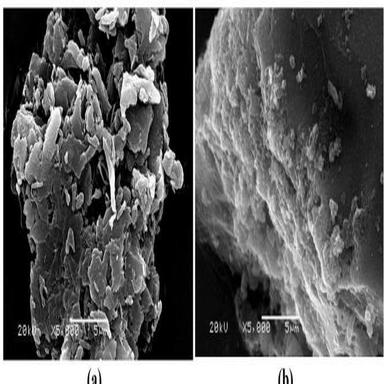
SEM micrographs from Ch (a) and m-Ch (b) samples.